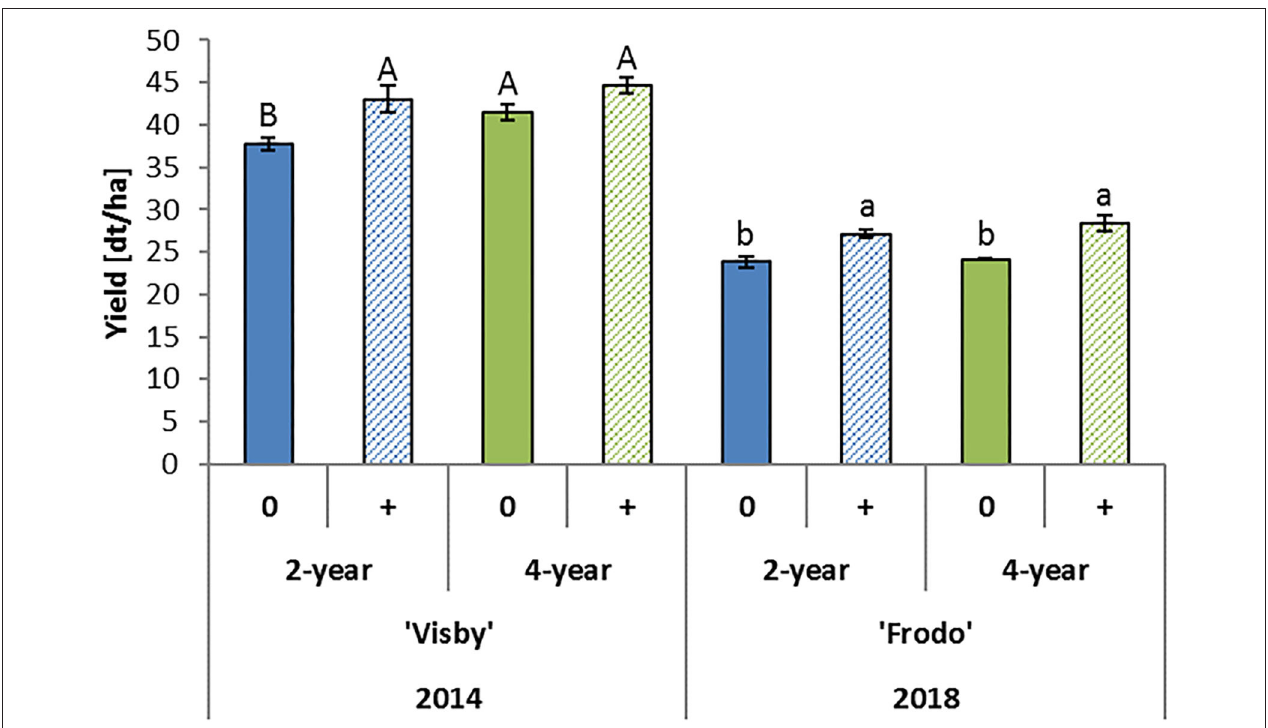
FIGURE 5 | Effect of insecticide application on yield of oilseed rape in the long-term crop rotation experiment in Göttingen Germany. Three insecticide treatments were applied in 2014 on 11th March at growth stage (GS, Weber and Bleiholder, 1990) 33 with 0.2 l/ha of Trebon (ethofenprox) against pollen beetle and on 1st April and 23rd April at GS 61 with 0.3 l/ha of Biscaya (thiacloprid) against aphids. In the season 2017/2018, insecticides were applied three times on 28th September 2017 at GS 15 with 0.3 l/ha of Bulldock (beta-cyfluthrin), on 10th April 2018 at GS 38 with 0.2 l/ha of Trebon and on 17th April 2018 at GS 51 with 0.17 l/ha of Avaunt (indoxacarb) against pollen beetle, respectively. Bars indicate standard errors. Different letters denote significant differences among treatments in each year (LSD test, P < 0.05). 0, without insecticide application; + , with insecticide application, 2-year, oilseed rape cultivated every two years; 4-year, oilseed rape cultivated every 4 years.